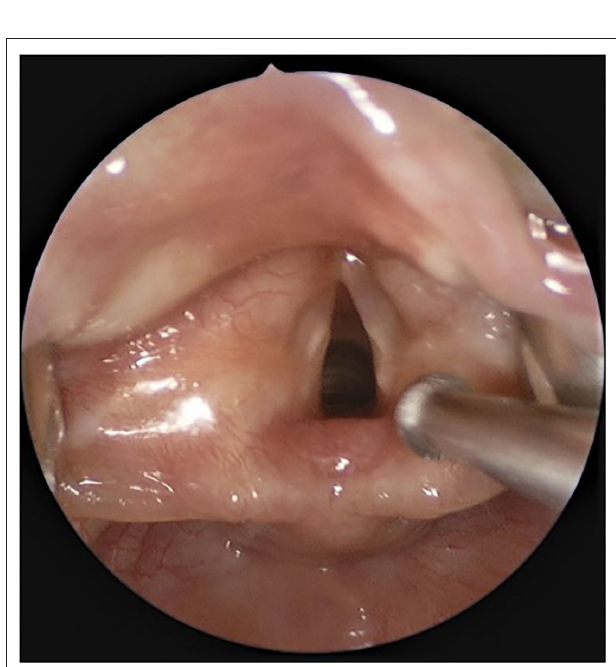
FIGURE 5 | Endoscopic view at 2 month follow up with no evidence of recurrence of the Laryngeal